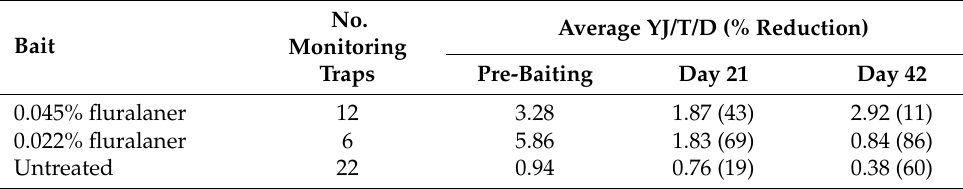
Table 5. The average number of yellowjackets trapped per trap per day (YJ/T/D) and percent reduc- tion after baiting with 0.022% and 0.045% fluralaner in PAA crystals at San Diego Zoo Safari Park a .